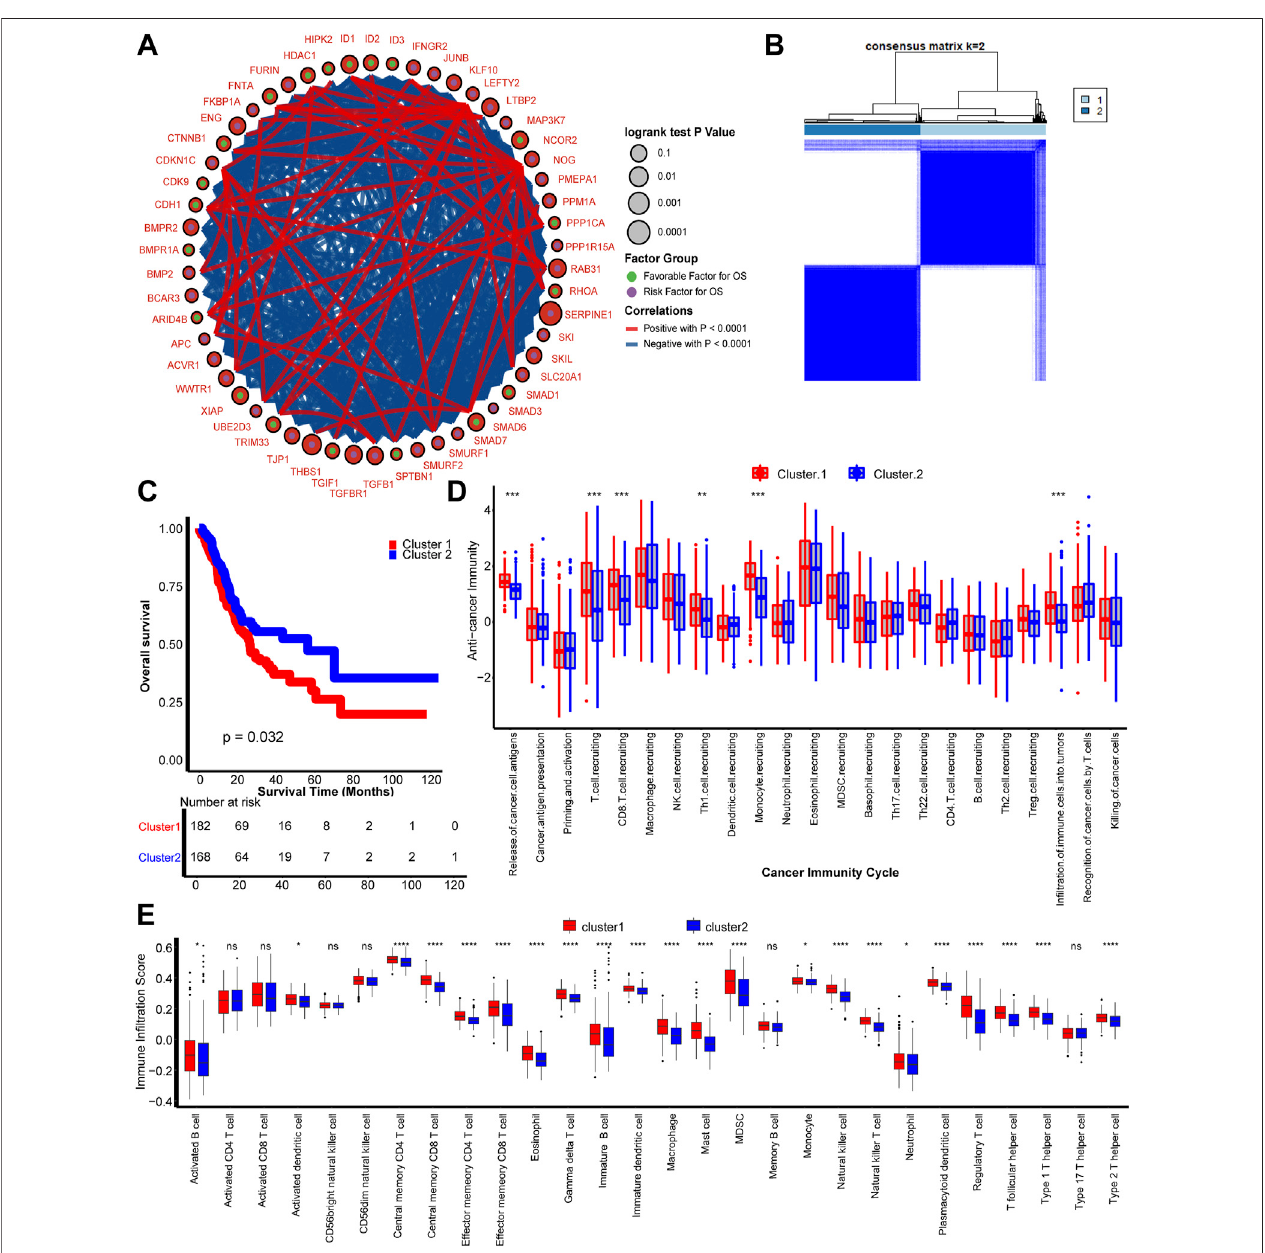
FIGURE1| TGF β patterns andcorrespondingtumor microenvironmentin fi ltration characterization. (A) Fifty-four TGF β pathway-relatedgenescorrelated withGC. Green and purple dots represent favorable and risk factors for overall survival respectively. The prognosis of each gene is expressed by the size of the circle. Curves betweenlinkeddotsshowthenegative(blue)andpositive(red)correlationbetweenTGFpathway-relatedgenes. (B) Theconsensusscorematrixshowsthatallsamples were grouped into clusters by the value of consensus score groups in different iterations (k = 2 in TCGA-STAD). (C) Survival analysis based on the TCGA-STAD dataset of TGF β Cluster1 (red) and TGF β Cluster 2 (blue). (D) Different activities of cancer immunity cycles between TGF β Cluster 1 (red) and TGF β Cluster 2 (blue). (E) TME immune cell in fi ltration scores between TGF β Cluster 1 (red) and TGF β Cluster 2 (blue). Ns, not signi fi cant; * p < 0.05; ** p < 0.01; *** p < 0.001; **** p < 0.0001.